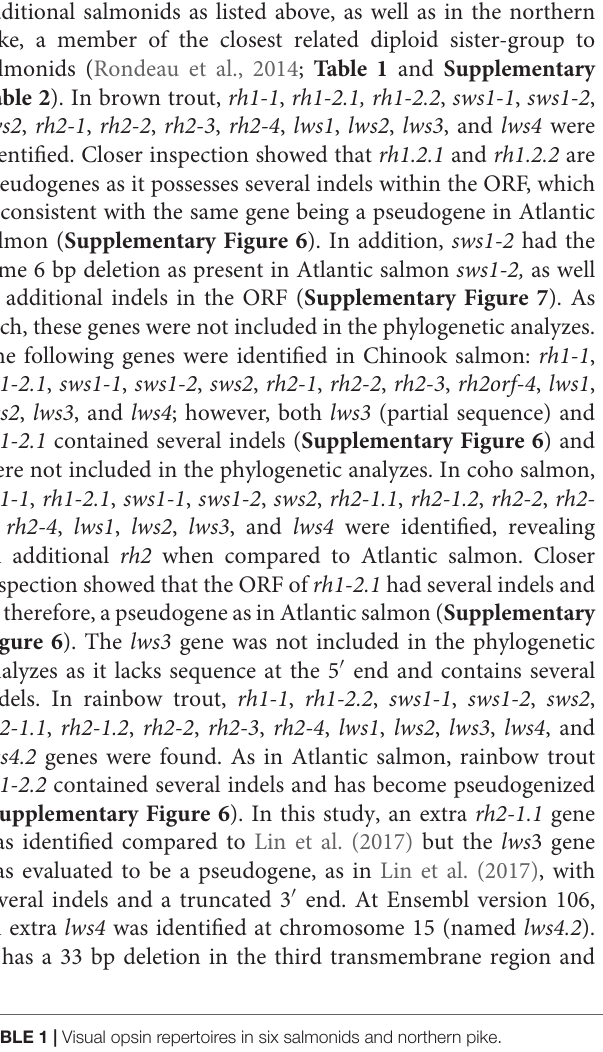
TABLE 1 | Visual opsin repertoires in six salmonids and northern pike.